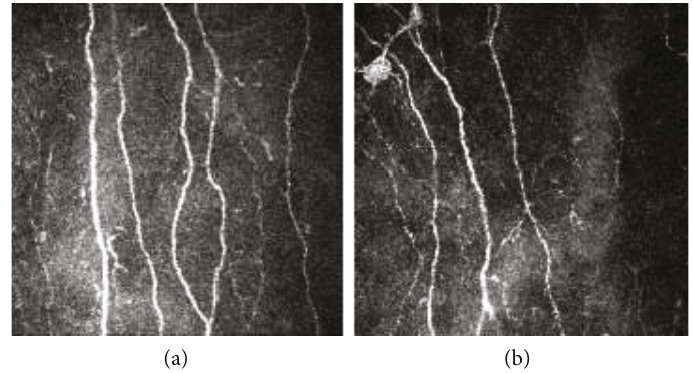
Figure 3: CCM images from a diabetic patient of group B at baseline (a) and follow-up (b). Table 3: Correlation coe ffi cients between corneal nerve parameters and other